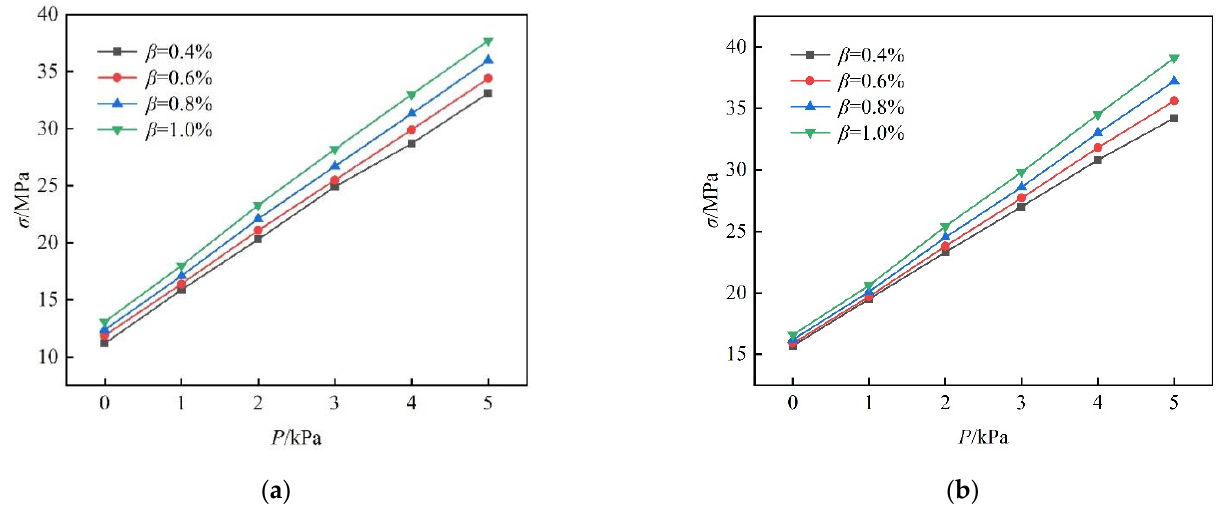
Figure 9. Relationship between coupling stress and uniform load. ( a ) SJ1 to SJ4; ( b ) SJ5 to SJ8.